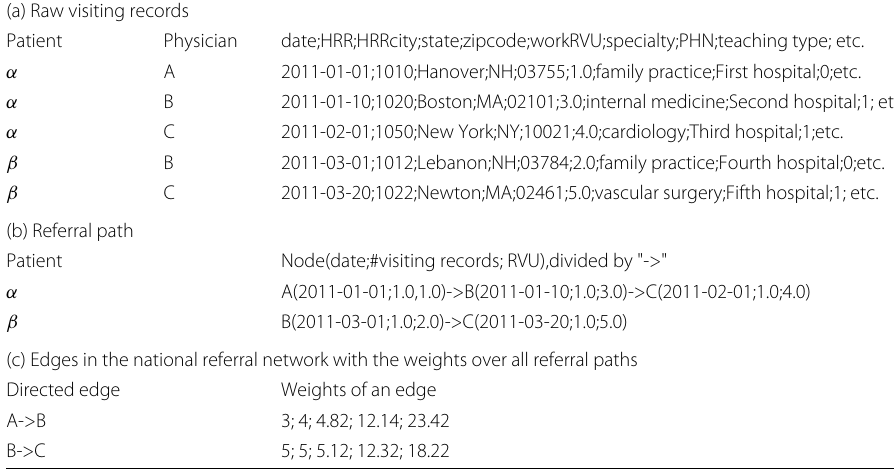
Table 1 Example pipeline of data processing from raw patient-physician encounter records to referral paths and edges of referral